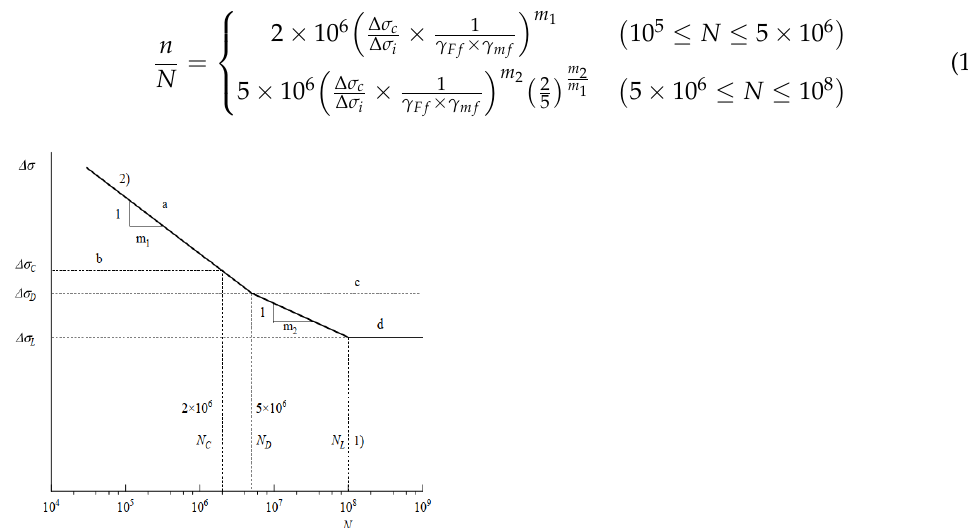
Figure 2. A typical fatigue strength S-N curve [23]; a — fatigue strength curve; b — reference fatigue strength; c — constant amplitude fatigue limit; and d — cut-off limit; 𝑚 1 and 𝑚 2 are the slope of the curve, 𝑚 2 = 𝑚 1 + 2